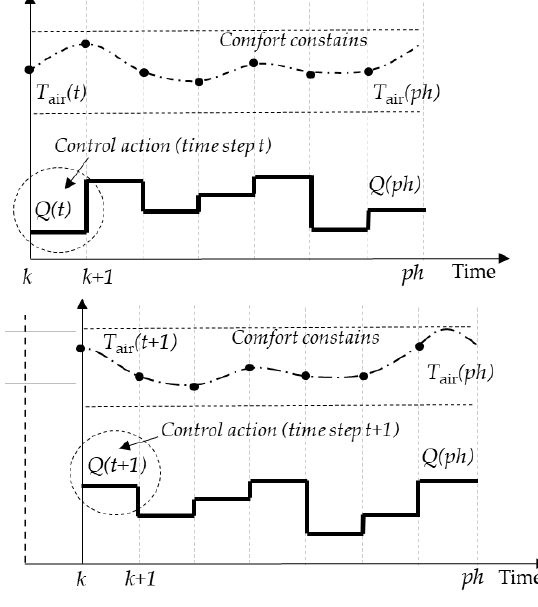
Figure 3. MPC receding horizon scheme.